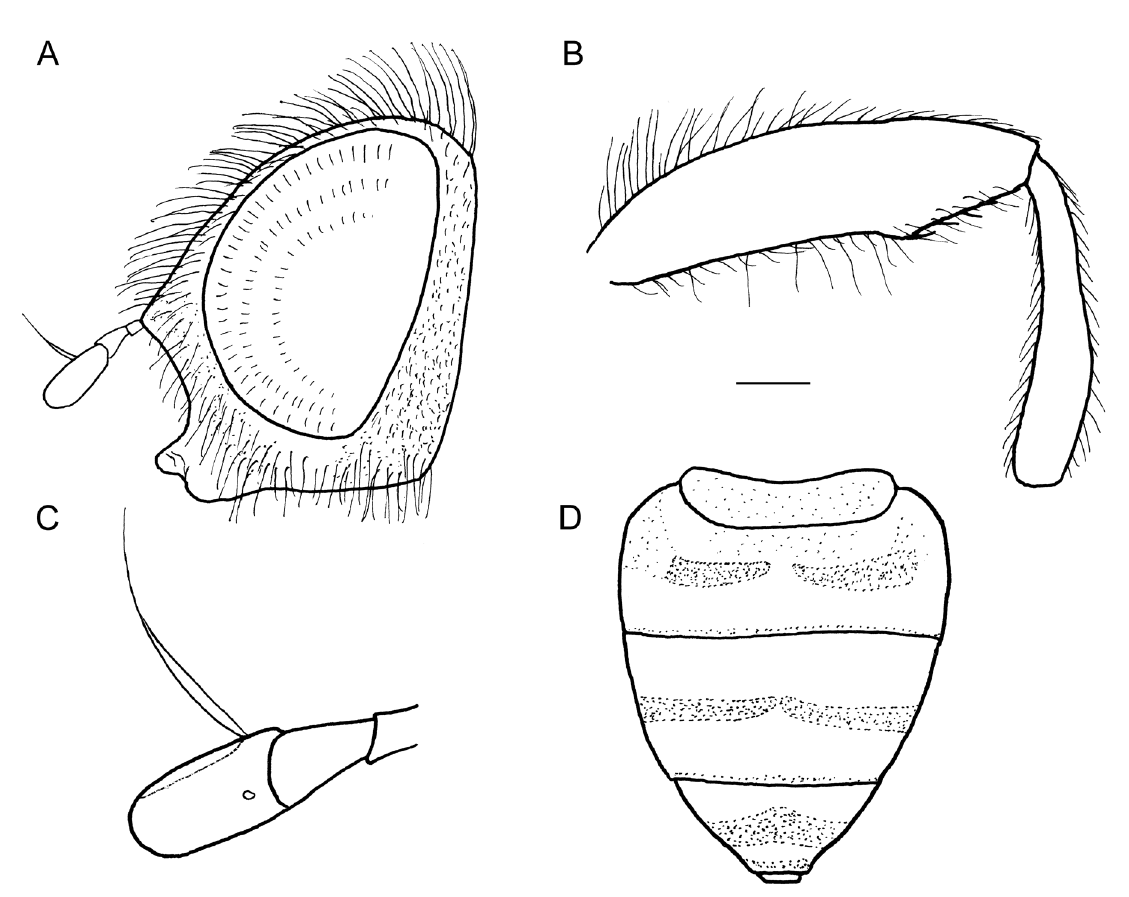
Fig. 20. Merodon nasicus Bezzi, 1915, lectotype, ♀ (BMNH NHMUK010369943). A . Head, lateral view. B . Metafemur and metatibia, lateral view. C . Antenna, lateral view. D . Abdomen, dorsal view. Scale bar = 1